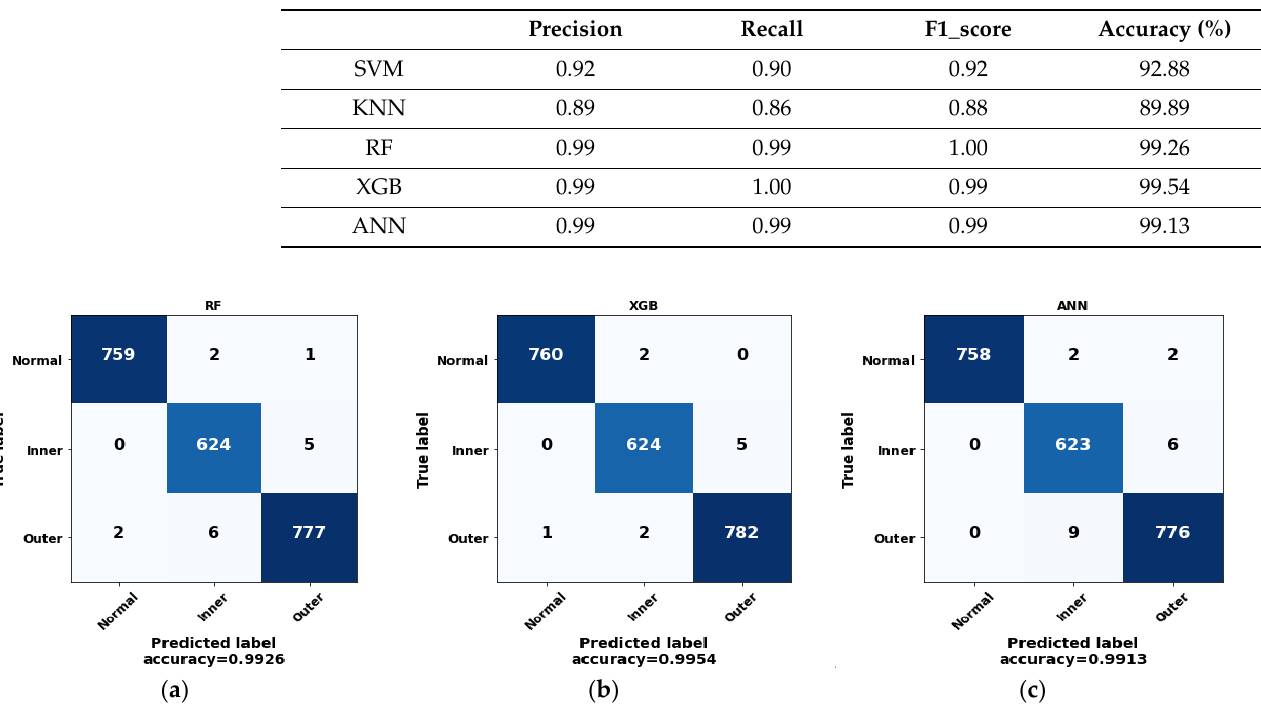
Figure 10. Confusion matrix of ( a ) RF, ( b ) XGB classifier, and ( c ) ANN. As can be seen from the confusion matrices, all three classifiers classify faults very accurately, with a negligible number of false positives and false negatives. The accuracy and loss curve for the ANN (up to 200 epochs) are provided in Figure 11. The accuracy curve indicates that the ANN model achieves a training accuracy of almost 100% and a testing accuracy of around 99%. After finishing 50 epochs, the model starts providing sta- ble accuracy values until the final epoch of the training process.